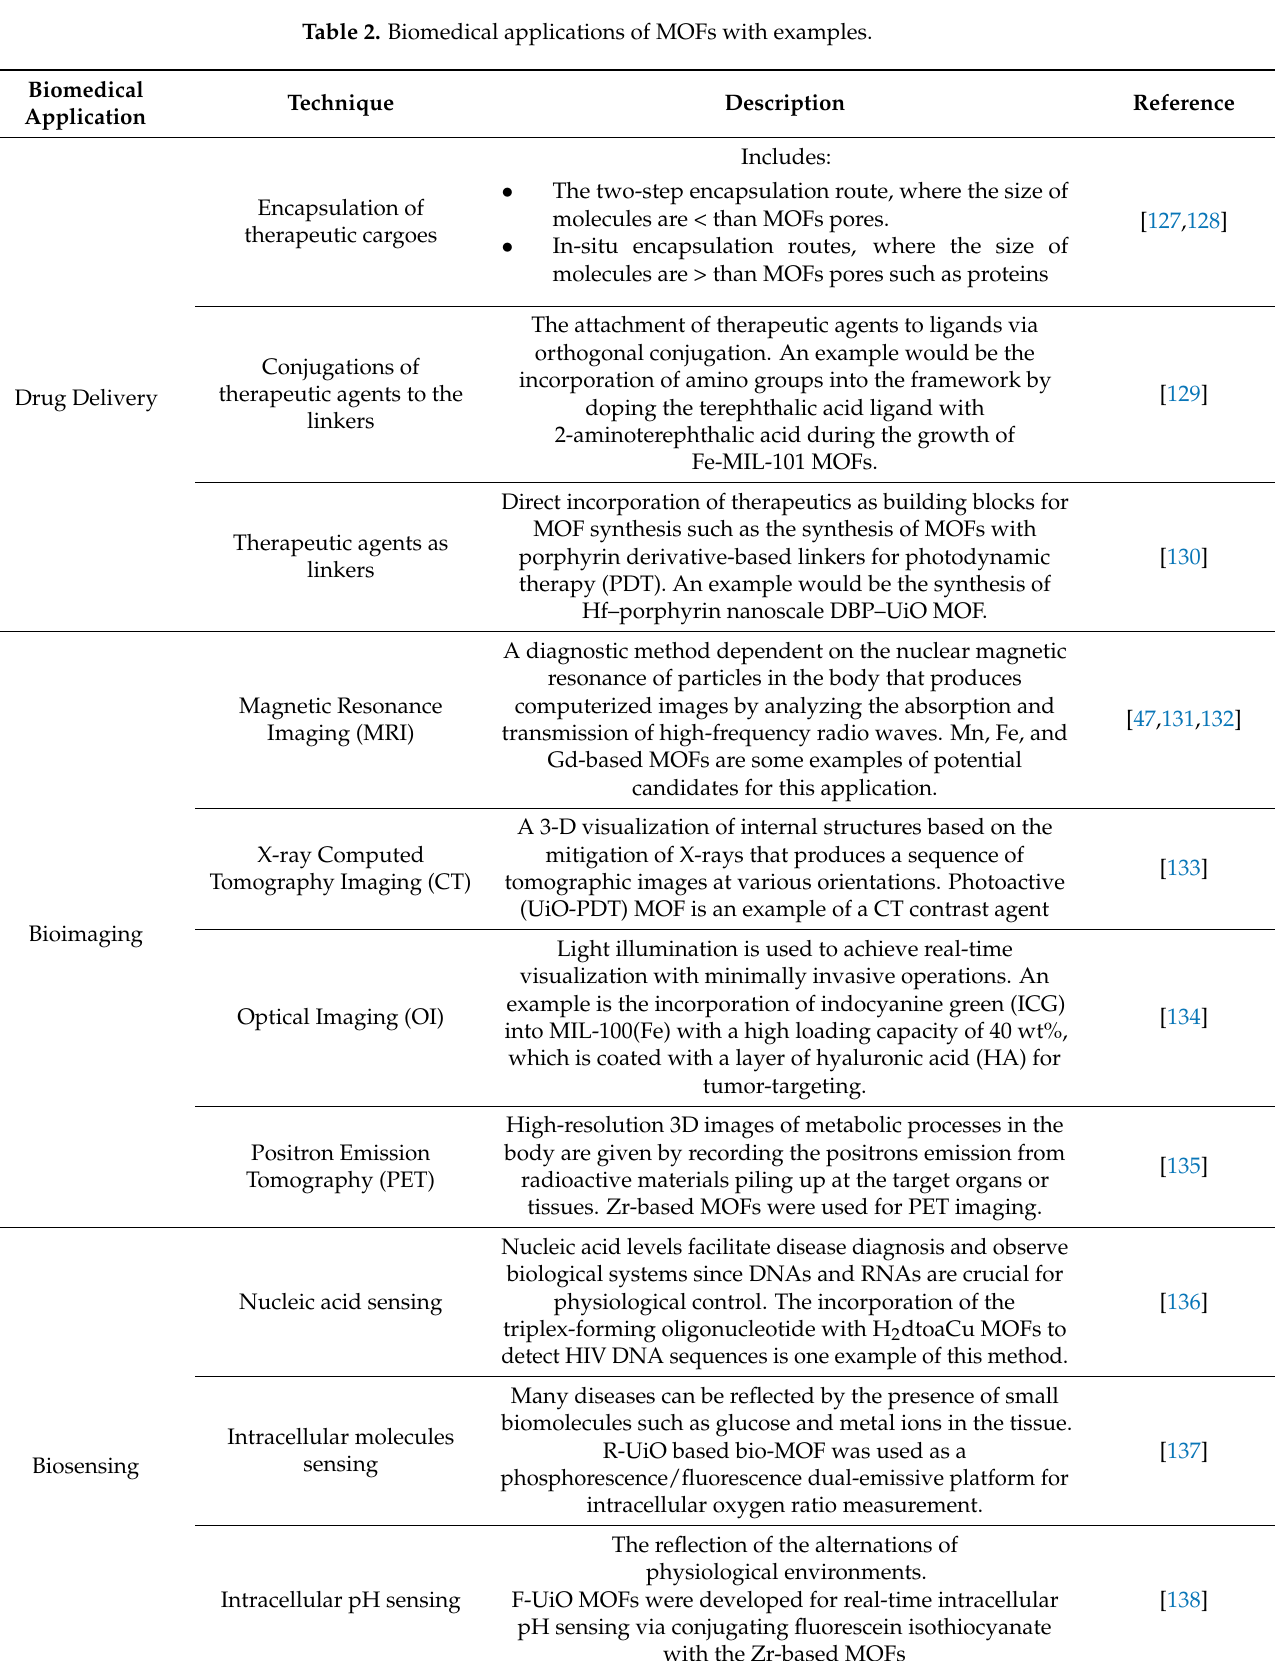
Table 2. Biomedical applications of MOFs with